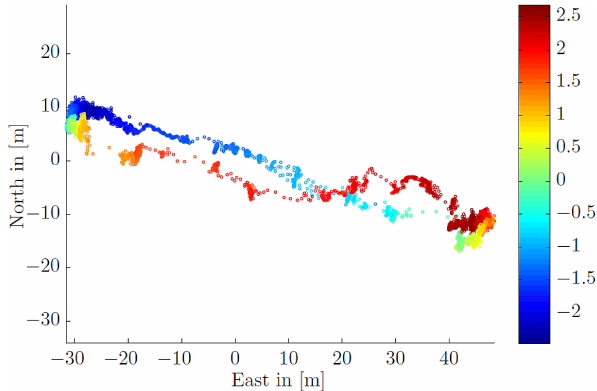
Figure 3. Three-dimensional position estimates of buoy 18 dur- ing one complete tidal cycle from high water to high water on 2 July 2011, plotted at a 60s interval. The marker is colour coded according to the elevation of the buoy in metres. The elevation is shown here with respect to the time-wise mean value. Note that the buoy only moves significantly in one direction. This is the dominant current direction, perpendicular to which only small-scale move- ment is observed. The origin represents the empirical mean of the